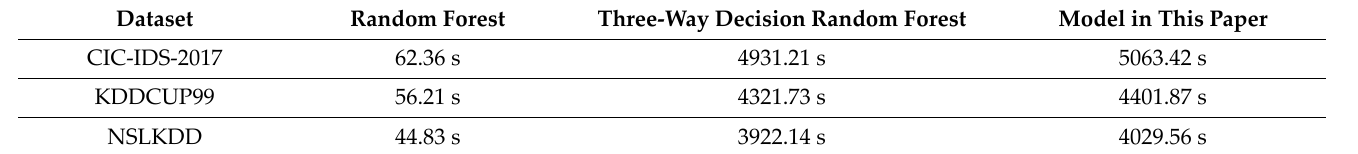
Table 9. Model training time